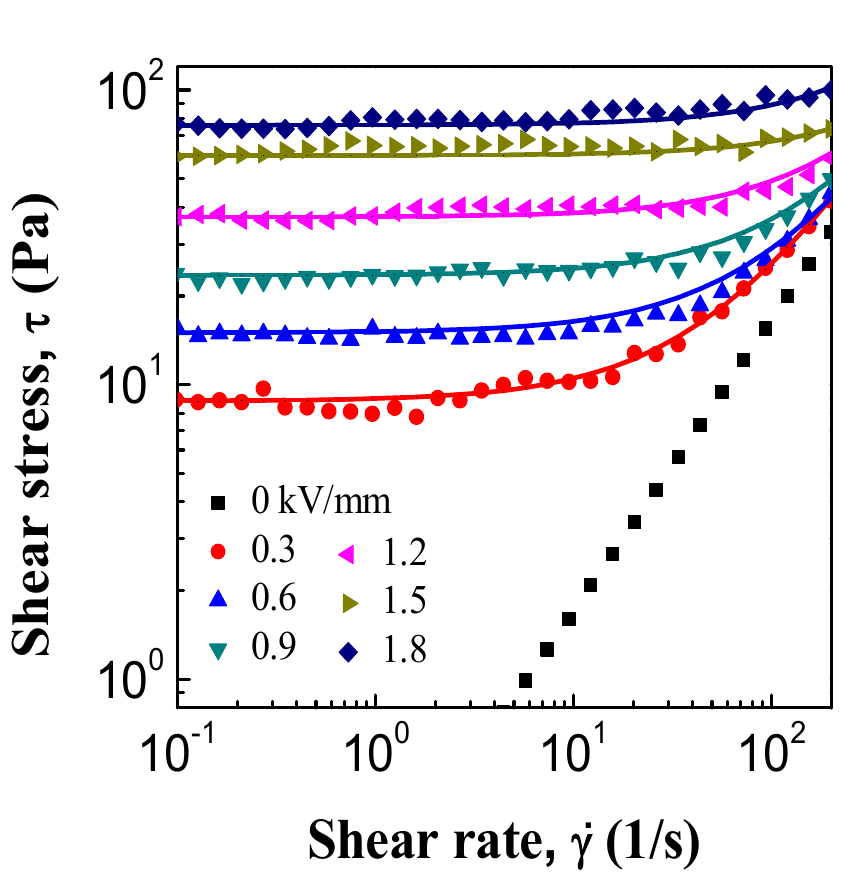
Figure 7. Shear stress vs. shear rate of the GO/PDPA microsheet composites-based ER fluid (10 vol.%) with different electric fields. The solid lines in graph are fitting from the Bingham fluid equation. The dynamic behaviors of the GO/PDPA microsheet-based ER fluid were characterized via amplitude sweep tests at a constant angular frequency of 6.28 rad/s (Figure 8a). Without the external